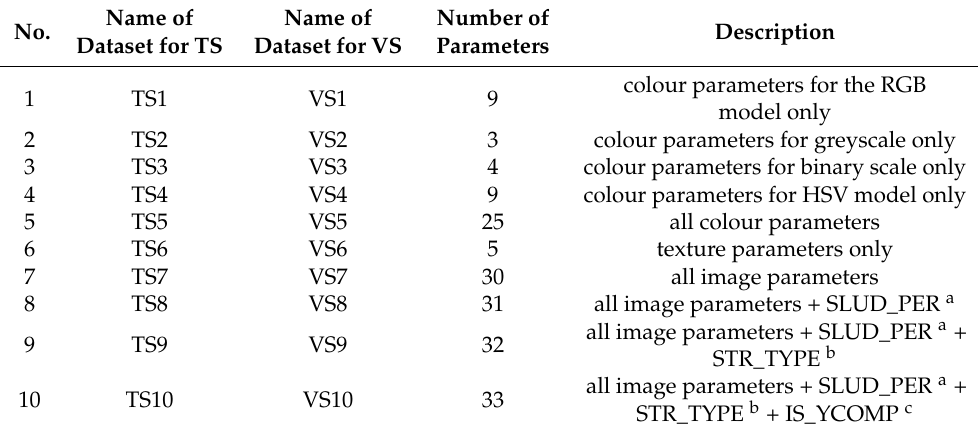
Table 3. Input parameters used in the